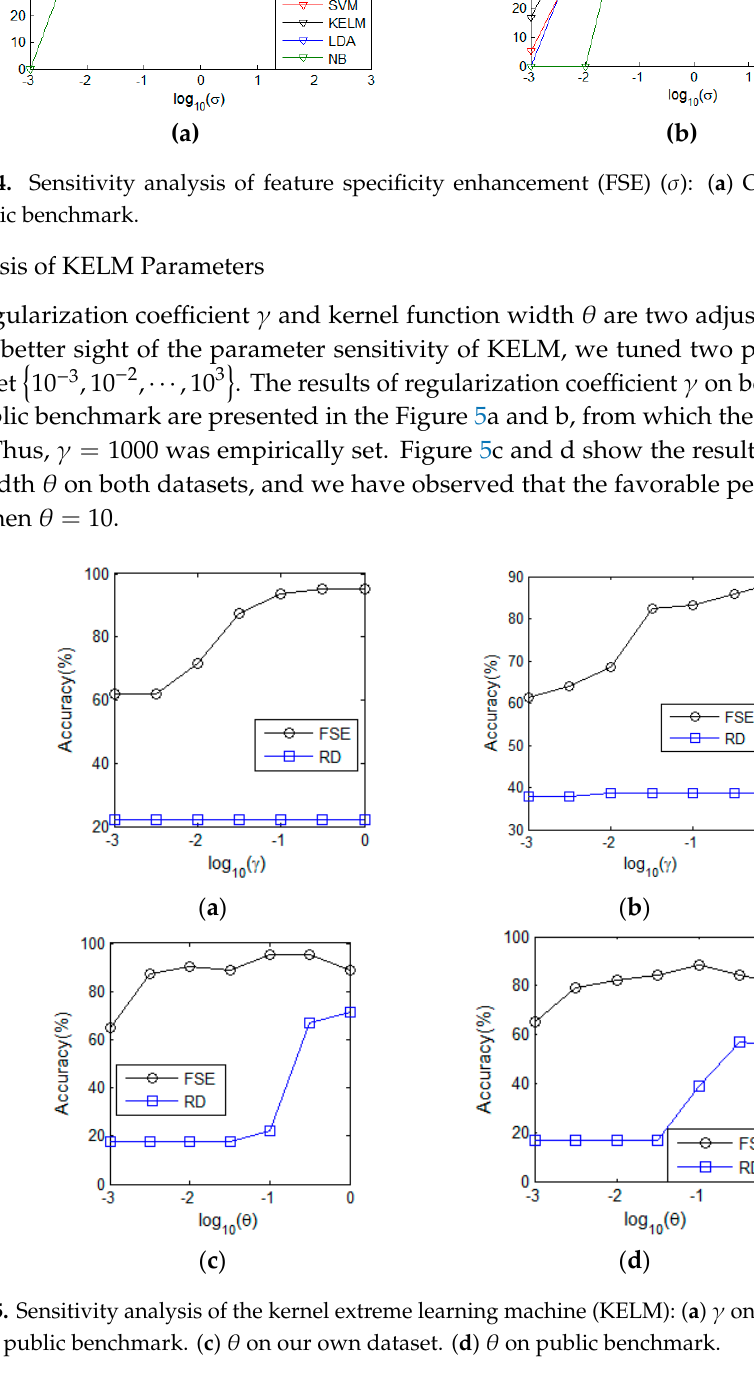
Figure 5. Sensitivity analysis of the kernel extreme learning machine (KELM): ( a ) γ on our own dataset. ( b ) γ on public benchmark. ( c ) θ on our own dataset. ( d ) θ on public